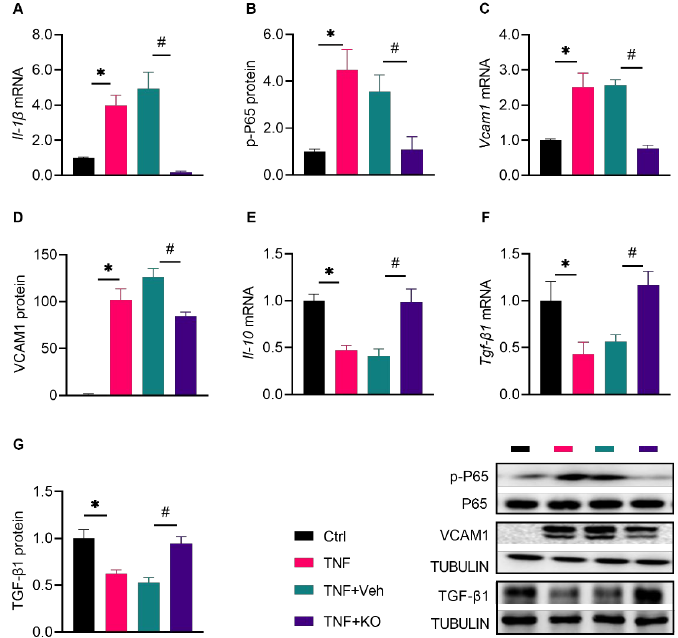
Figure 4. KO alleviated the TNF-α-induced macrophage inflammation. ( A ) Il-1β mRNA levels, ( B ) protein ratio of p -P65 to P65, ( C ) Vcam1 mRNA levels, ( D ) VCAM1 protein levels, and ( E ) Il-10 mRNA levels, as well as ( F ) Tgf -β1 mRNA and ( G ) protein levels were determined. The data were normalized to Ctrl, and summarized as means ± SD. *, p < 0.05 vs. Ctrl; #, p < 0.05 vs. DM. Il-10 , Interleukin-10; TGF-β1, transforming growth factor β 1; VCAM1, vascular cell adhesion molecule 1. The other abbreviations are the same as in Figure 3.